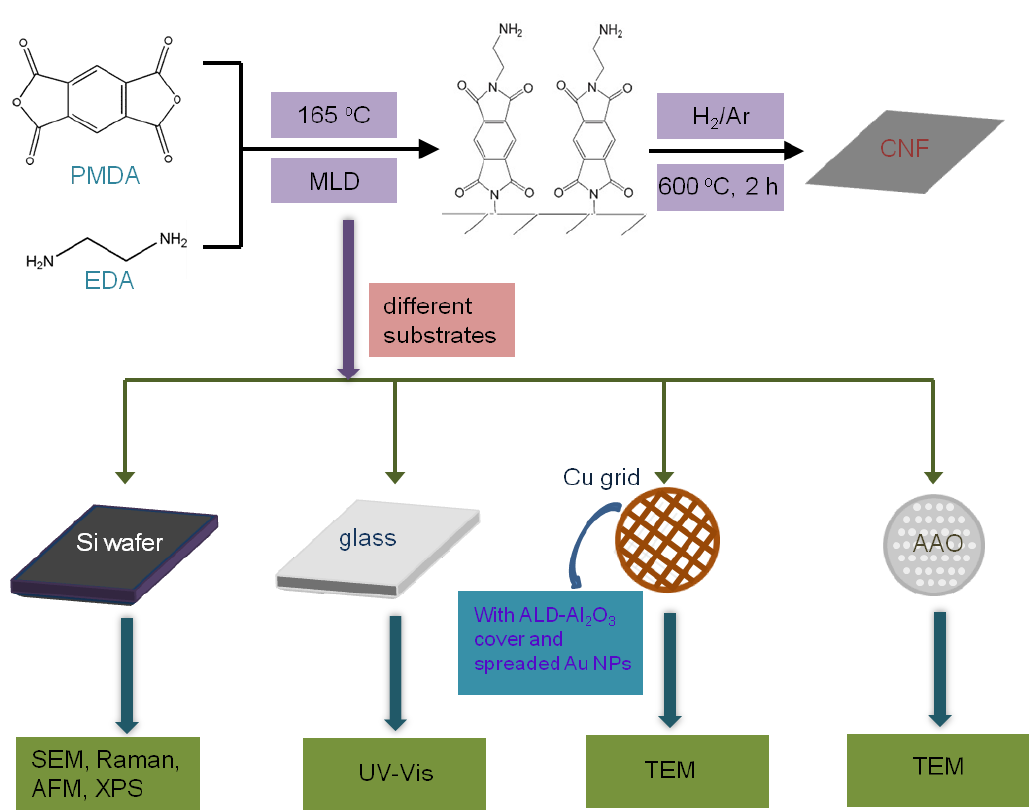
Figure 1. Scheme of the experimental